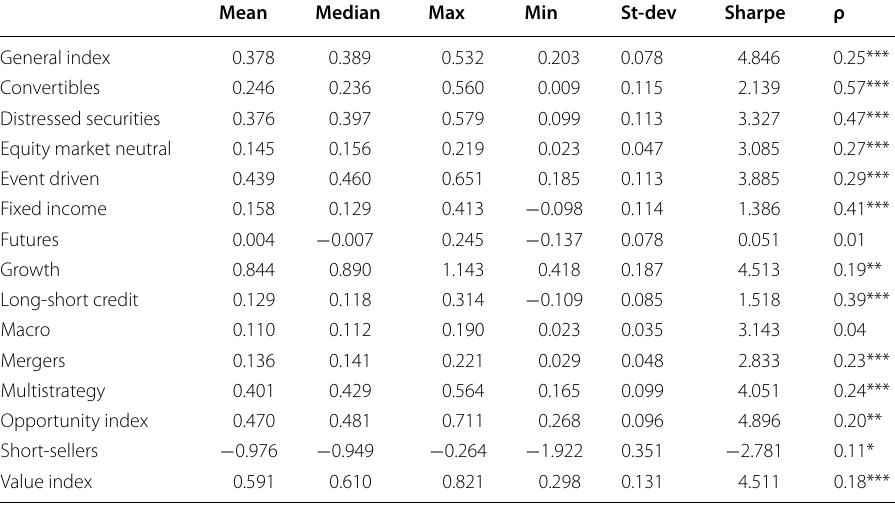
cov t ( R i , R m ) The time‑varying beta of strategy i is equal to: β it = var t ( R m ) , where R i is the return of strategy i and R m is the market return, as measured by the S&P500’s return. The covariance and variance measures are computed with the MGARCH algorithm (Bollerslev et al. 1988; Engle and Colacito 2006; Engle 2016). The ρ coefficient associated with a strategy is equal to the coefficient of autocorrelation of the first‑order degree of its return. The significance levels of the p‑values are 1% indicated by ***; 5%, **; and 10%,